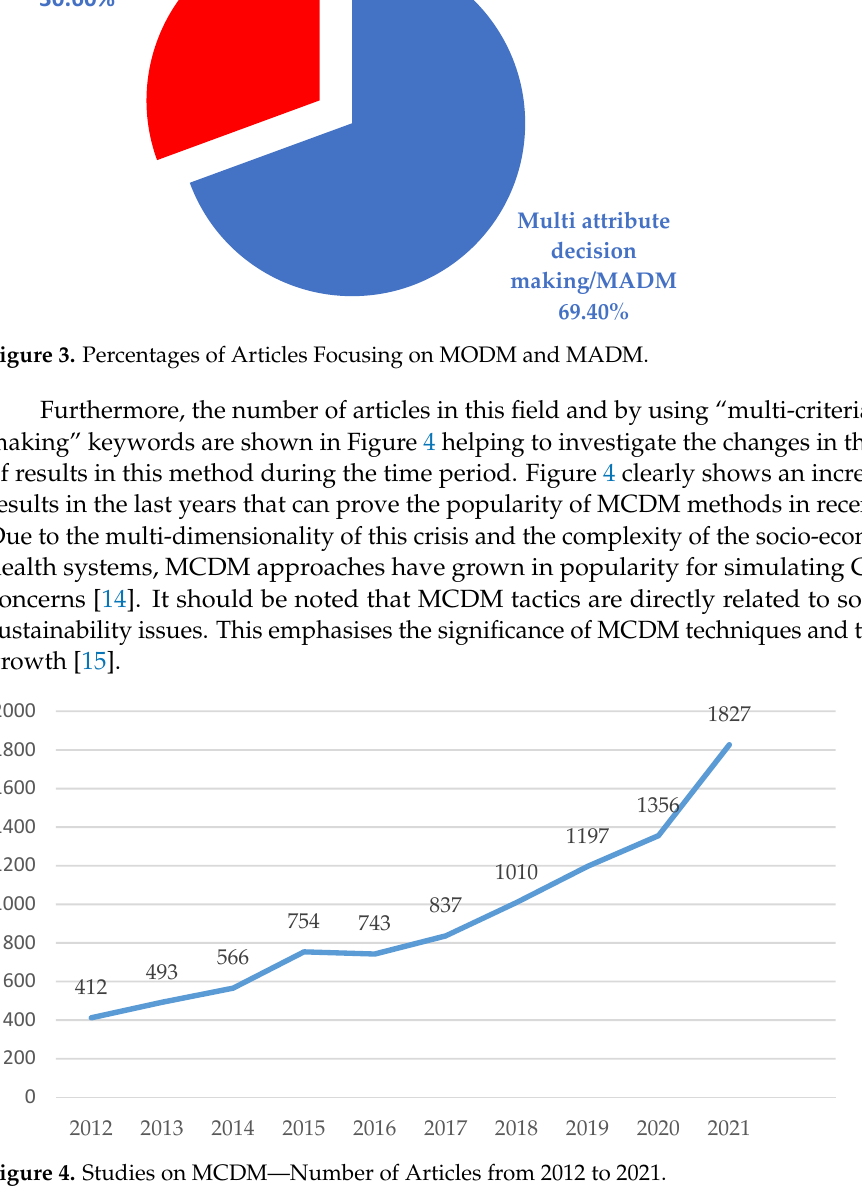
Figure 5. Subject Areas in MCDM Studies—Number of Articles based on Subject Area. The next part of this section is provided to investigate the prevalence of using differ- ent MCDM methods in different articles. For this purpose, firstly, a list including 60 dif- ferent methods is provided that are taken from manifold literature reviews and research articles. The methods and number of results (based on the “ScienceDirect” database, and between 2012 and 2022 conducted on 21 April 2022) are listed in Table 3. It should be